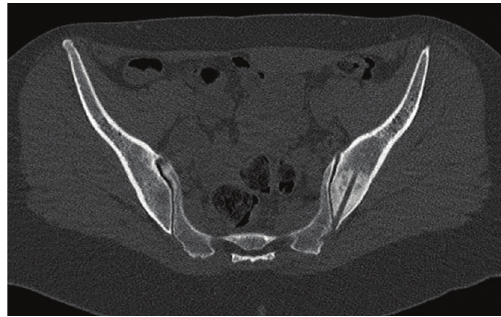
Figure 2: CT scan of the pelvis of a 33-year-old lady with low back pain. X-rays were normal as was an MRI of the lumbar spine. A bone scan showed increased activity in the ilium adjacent to the sacroiliac joint, and a CT showed a dense sclerotic lesion. This would have been typical for fibrous dysplasia radiologically, but this did not explain the pain. CT-guided needle biopsy confirmed the diagnosis. This CT image clearly shows the lesion and the path of the